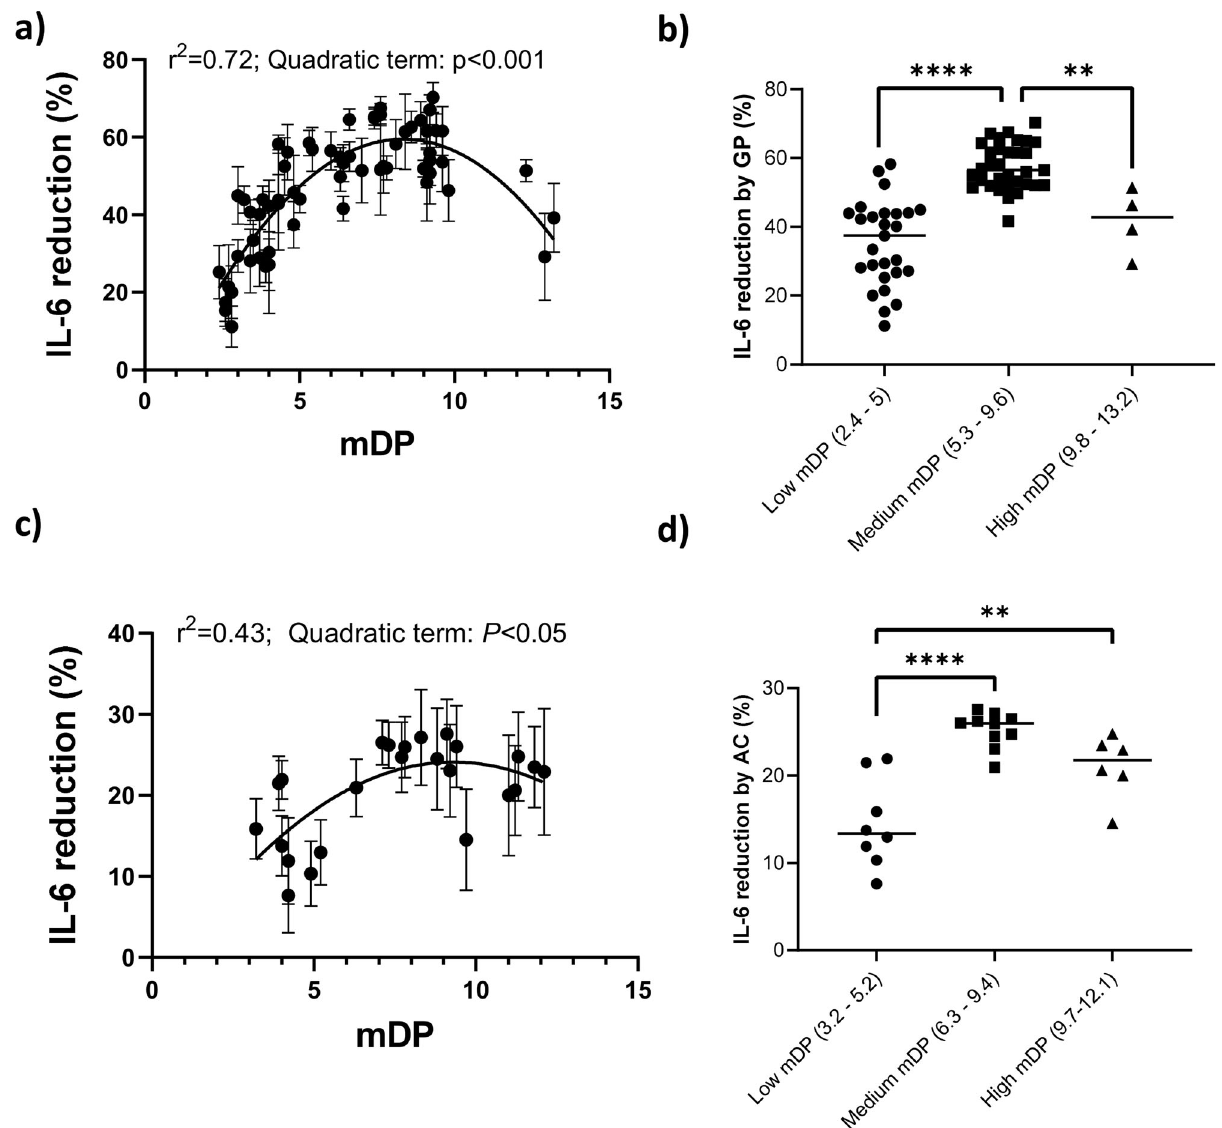
Fig. 2 Suppression of IL-6 secretion in lipopolysaccharide-activated macrophages by proanthocyanidins is in fl uenced by polymerization. a Proanthocyanidins (PAC) derived from grape pomace (GP) reduced IL-6 secretion in lipopolysaccharide (LPS)-activated macrophages, with the relationship between mDP and IL-6 reduction best described by a quadratic function (quadratic regression with curve- fi tting analysis). Each data point represents mean and SEM of at least three independent experiments. b IL-6 reduction in GP PAC samples strati fi ed into low, medium, and high mDP. c PAC derived from alpine currant (AC) reduced IL-6 secretion in lipopolysaccharide (LPS)-activated macrophages, with the relationship between mDP and IL-6 reduction best described by a quadratic function (quadratic regression with curve- fi tting analysis). Each data point represents mean and SEM of at least three independent experiments. d IL-6 reduction in AC PAC samples strati fi ed into low, medium, and high mDP. * p < 0.05, ** p < 0.01, *** p < 0.001 by one-way ANOVA. All samples were tested at 15 µ